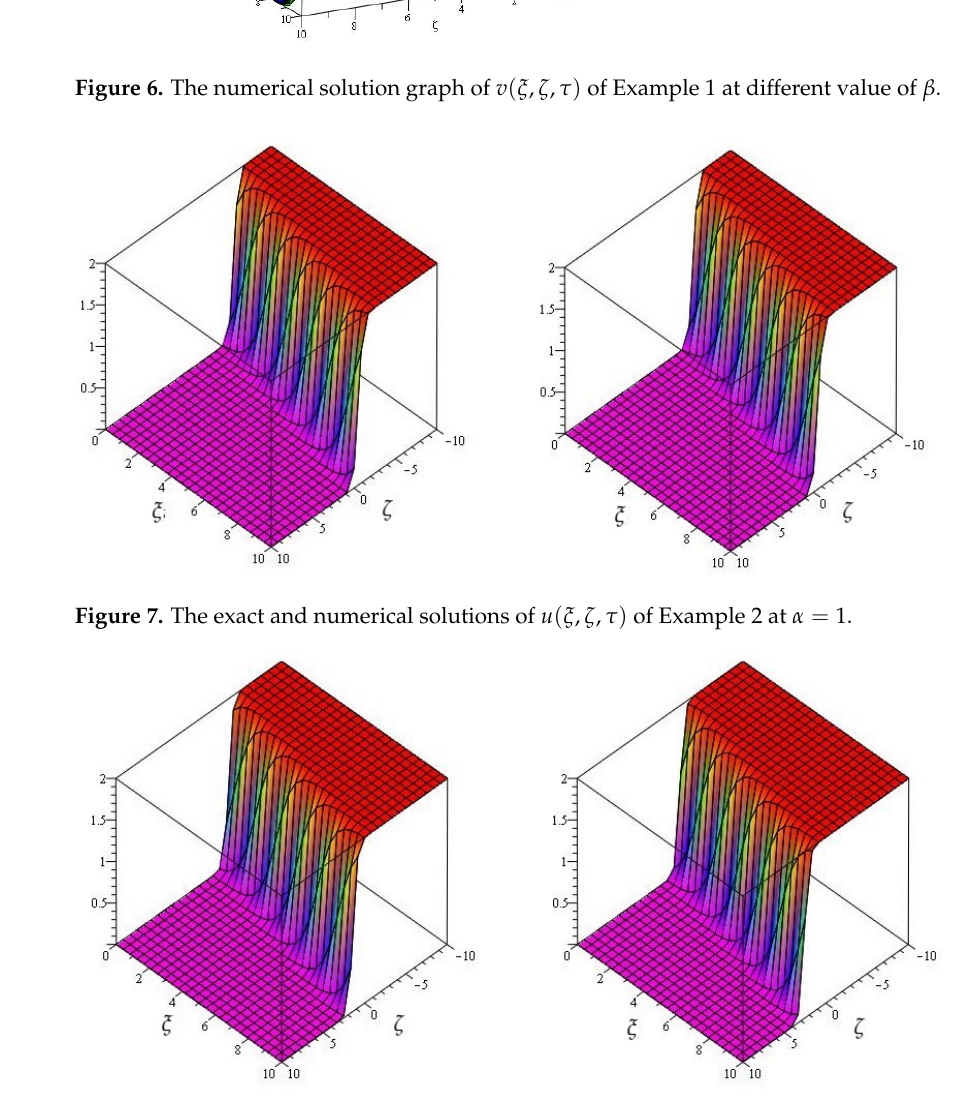
Figure 8. The numerical solution graph of u ( ξ , ζ , τ ) of Example 2 at α = 0.8 and